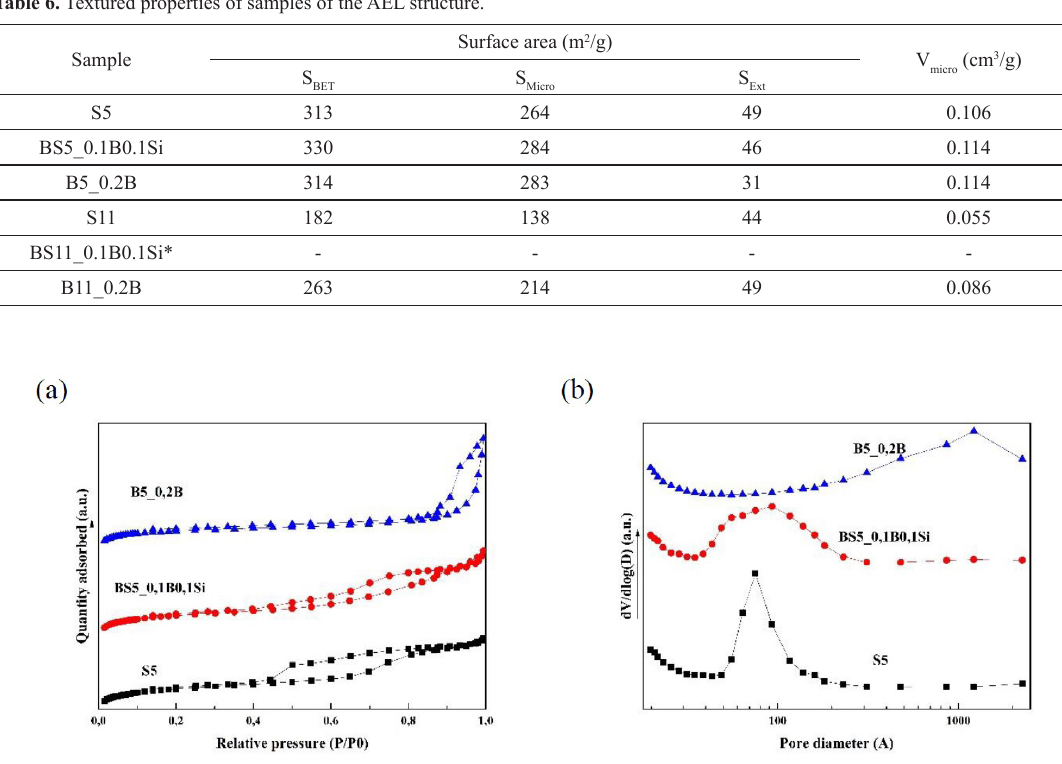
adsorption/desorption and (b) pore distribution of AFI structure samples. Figure 11. (a) Isotherms of N 2